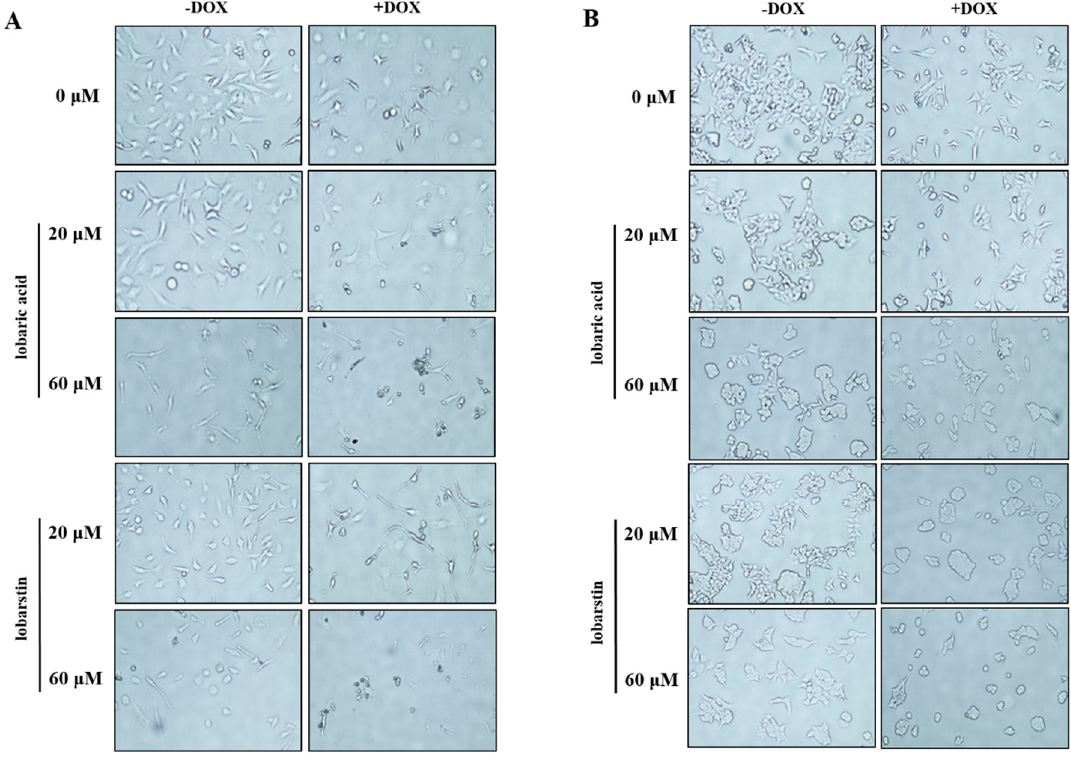
Figure 3. Morphological changes of ( A ) HeLa and ( B ) HCT116 cells treated by lobaric acid and lobarstin at the concentration of 20 and 60 μ M for 24 h. Light microscopy photographs are shown (20× objective).